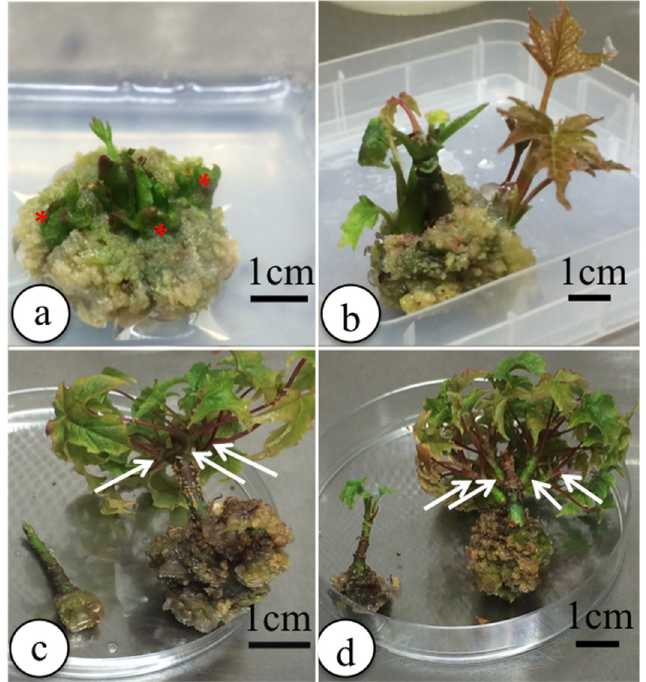
Figure 4. The effect of apex removal (decapitation) on shoot multiplication. Multiple shoots devel- oped on DKW medium supplemented with 0.1 ( a ) or 0.01 ( b ) μ M TDZ and grown for 1 month. The right shoot in ( b ) was split into an apical and basal segment and cultured side by side on medium with 0.01 μ M TDZ. After 1 month, the apical shoot had produced leaves (removed for clarity) but no axillary shoots ( c ), whereas the basal segment had produced multiple axillary shoots (arrows in c ). The same treatment of the left shoot in ( b ) had the same outcome ( d ). Red asterisks in ( a ) indicates shoots formed de novo from callus.